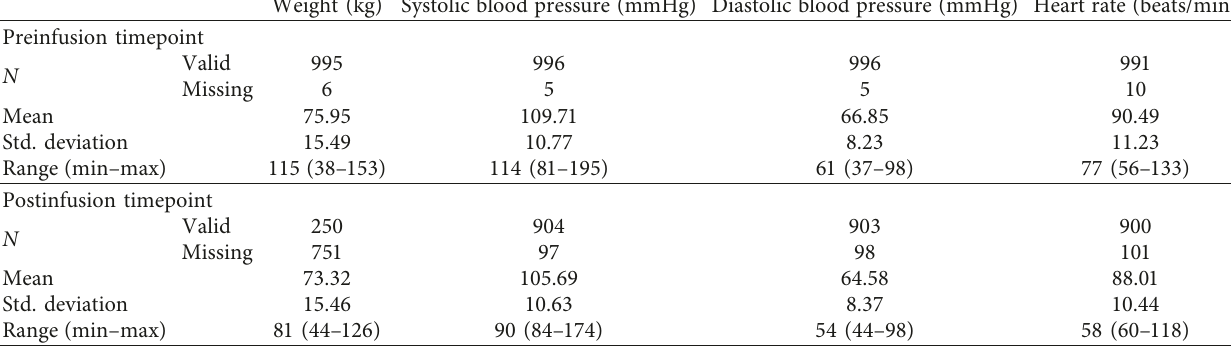
Table 1: Body weight and vital signs (pre- and postinfusion timepoint).